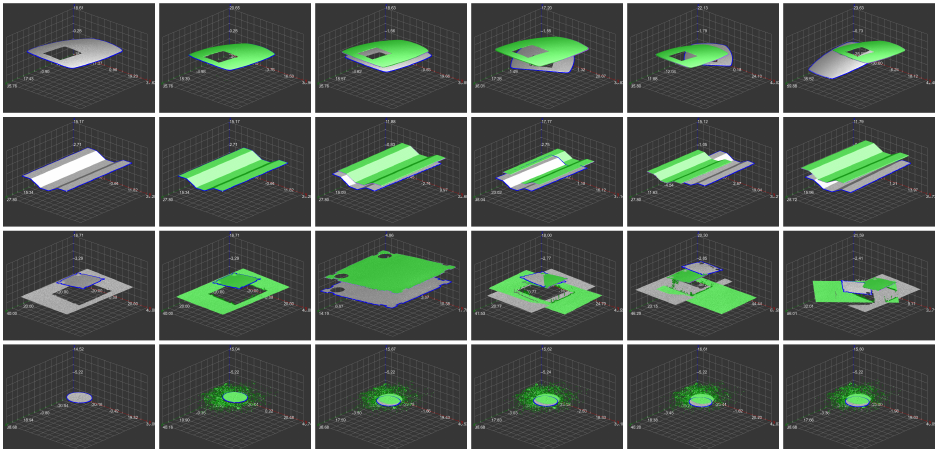
Figure 9. Here, we present results for several objects and their scans. Each line offers five scans of the same item, from which the first one we select as the template (the first column). The gray color represents measured values while the green one the aligned depth map (we align the whole depth map for better comparison; the recognized object could also be separated, of